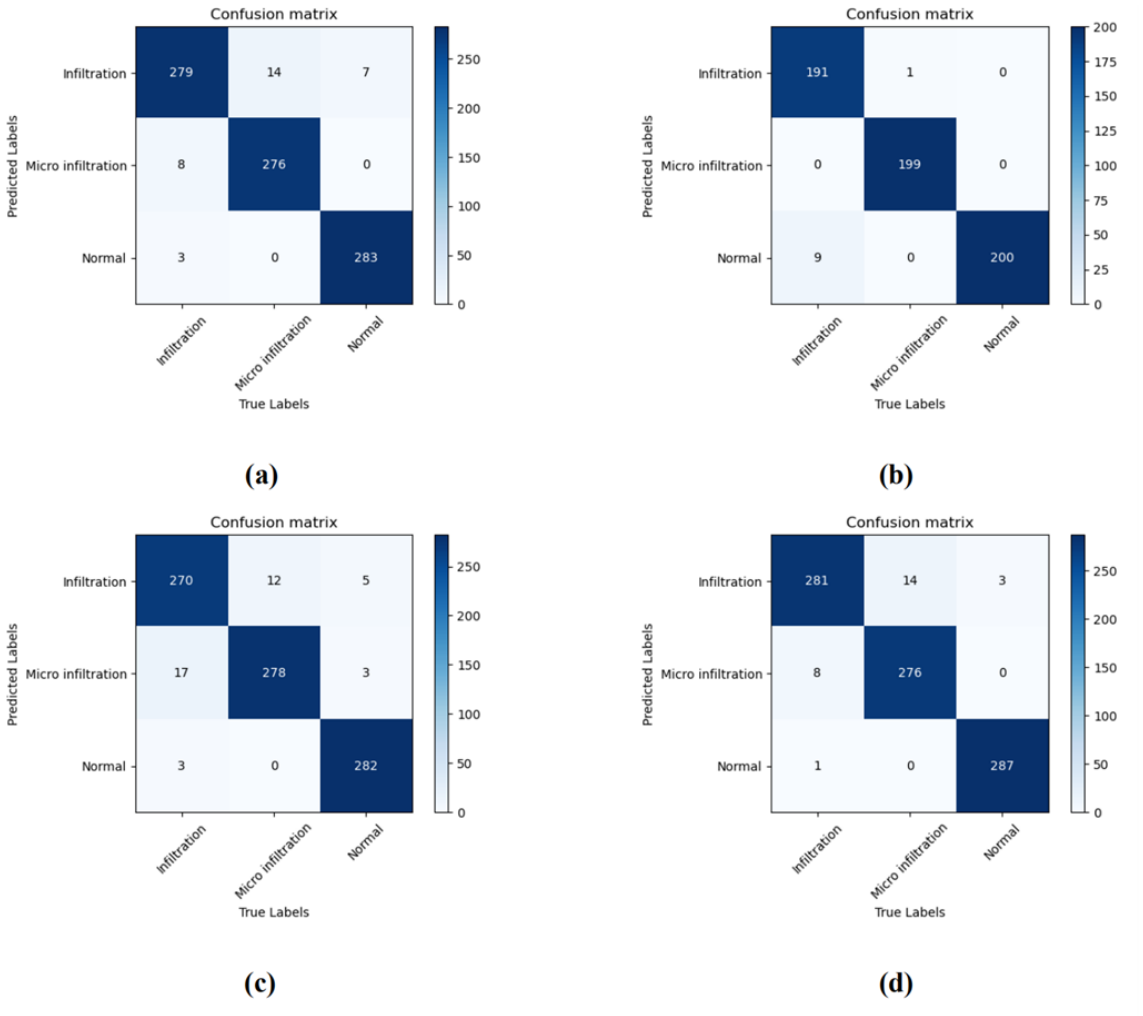
Figure 5. The confusion matrix obtained by the model on a private dataset. ( a ) SENet50; ( b ) SENet50_CroReLU; ( c ) MobileNet; ( d )